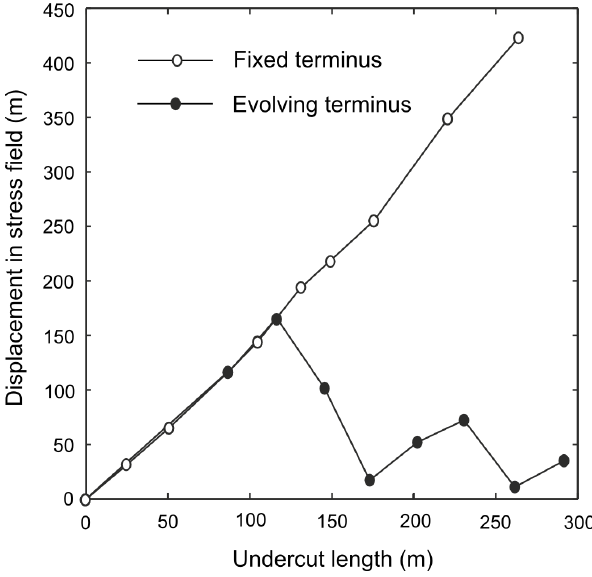
Fig. 9. Displacement in stress field caused by undercut cavities of varying length, applied with both a fixed and evolving terminus. When the terminus is allowed to evolve, the ice displacement coun- terbalances the change in the stress field caused by the applied cav-